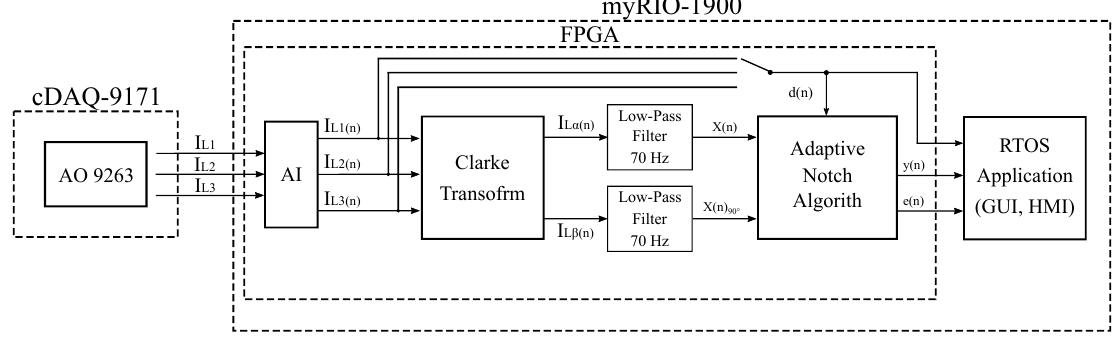
Figure 22. Diagram of the conducted